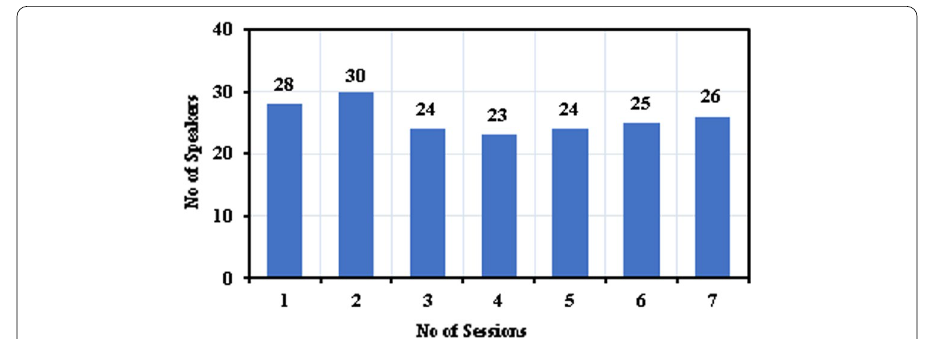
Fig. 2 Recording sessions with corresponding